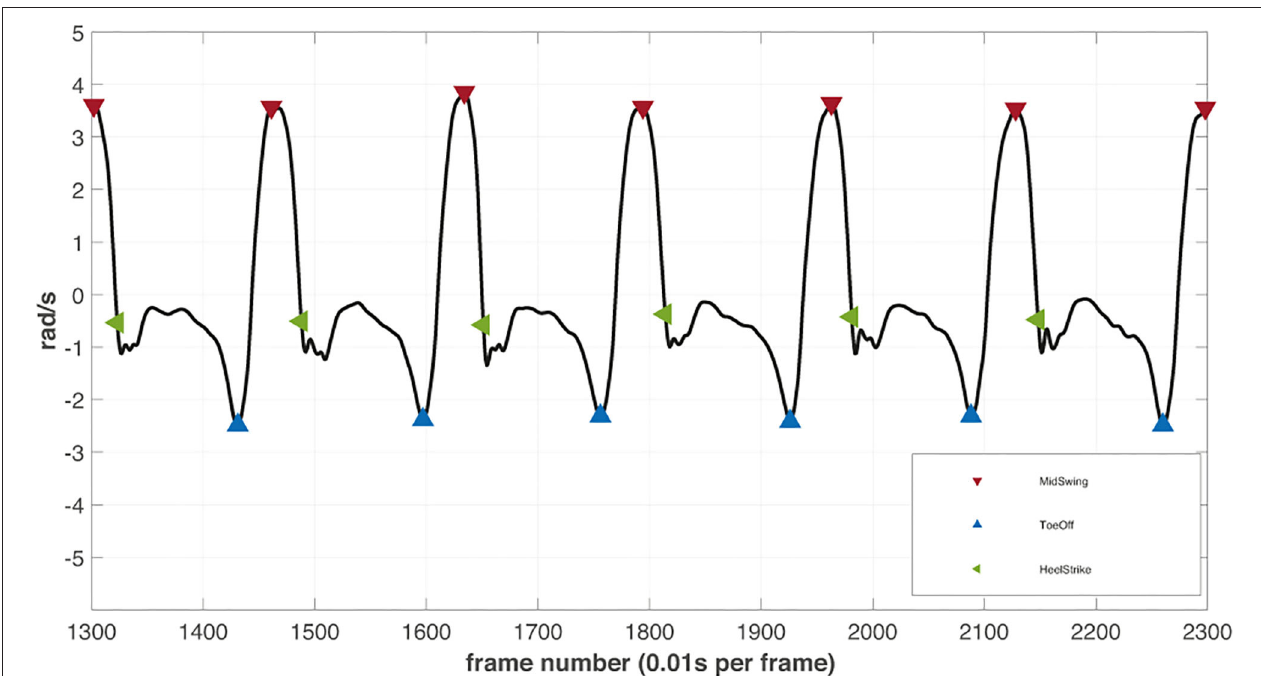
FIGURE 4 | The illustrative example of filtered angular velocity signal from the right ankle inertial motion tracker with detected gait events. The detected peaks (red) in the signals are defined as mid-swing phases of every step. The lowest valley right before the mid-swing peaks are assumed to depict the toe-off events (blue). The datapoint at the zero-crossing event after every mid-swing peak determines the heel strike (green) of the next step. p -values were calculated, using the Tukey method to adjust